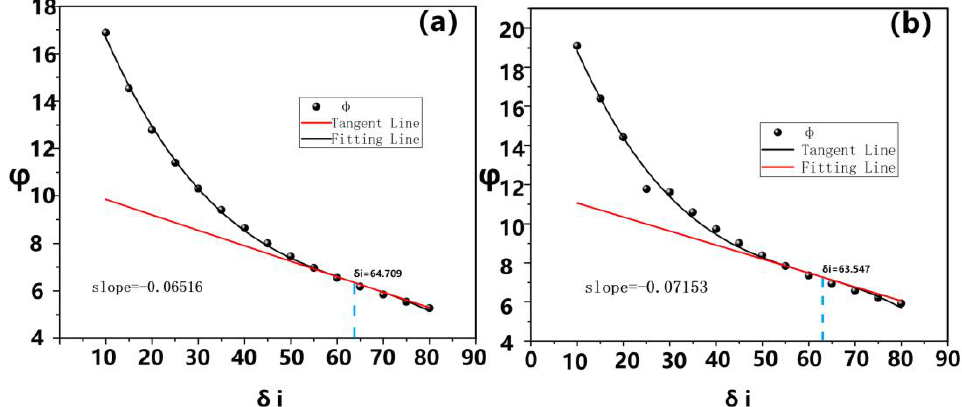
Figure 7. The impact of thickness on the wall energy-saving rate: ( a ) Exterior wall energy-saving